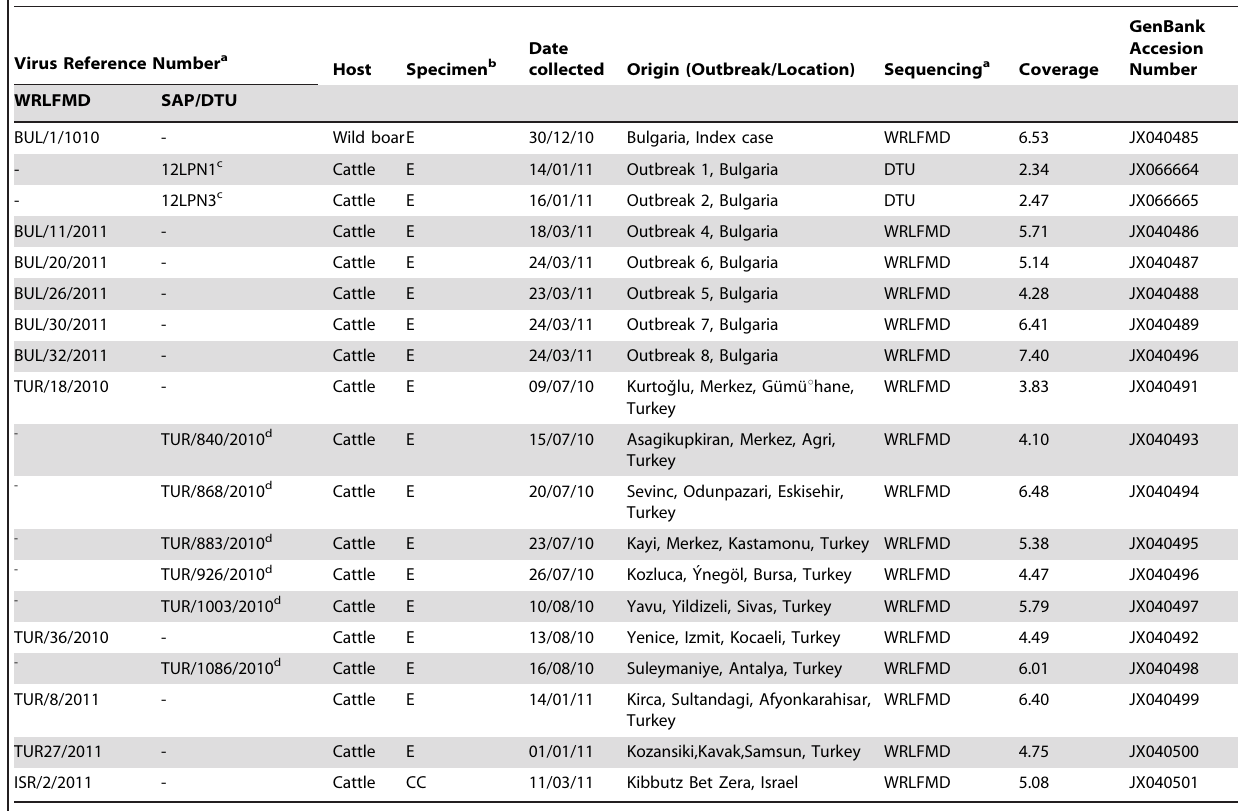
Table 2. Summary of full genome sequenced viruses generated in this study.